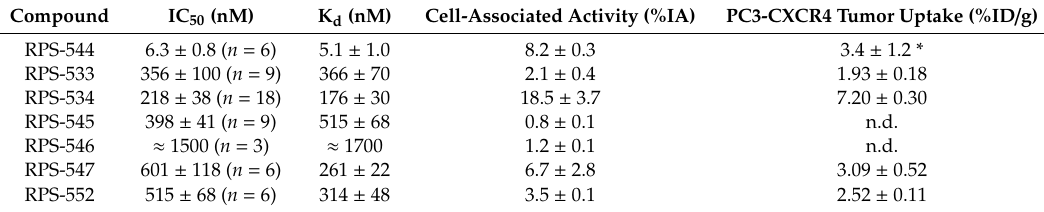
Table 2. Comparison of key parameters in PC3-CXCR4 cells and PC3-CXCR4 xenograft tumors. IC 50 was determined by competition binding against [ 68 Ga]Pentixafor. PC3-CXCR4 cell and tumor uptake was determined at 1 h p.i. Cell-associated activity is defined as the percentage of initial activity (%IA) remaining after removal of media and washing of cells. Values are expressed as mean ±